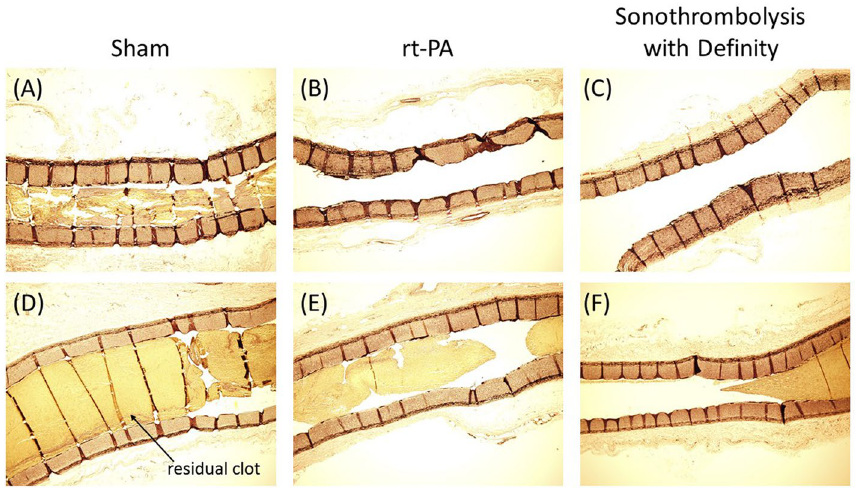
Figure 4. Representative longitudinal histology images of residual clot burden in APAs with Verhoeff-Van Giessen (VVG) stain. Residual clot volume can be seen in vessels in the sham treatment arm ( A , D ) rt-PA only treatment arm ( B , E ) or the sonothrombolysis with Definity treatment arm. Images A – C show vessels for which the perfusion was graded as ≥ 2b at 120 min on the mTICI scale and images D-F show vessels graded < 2b at 120